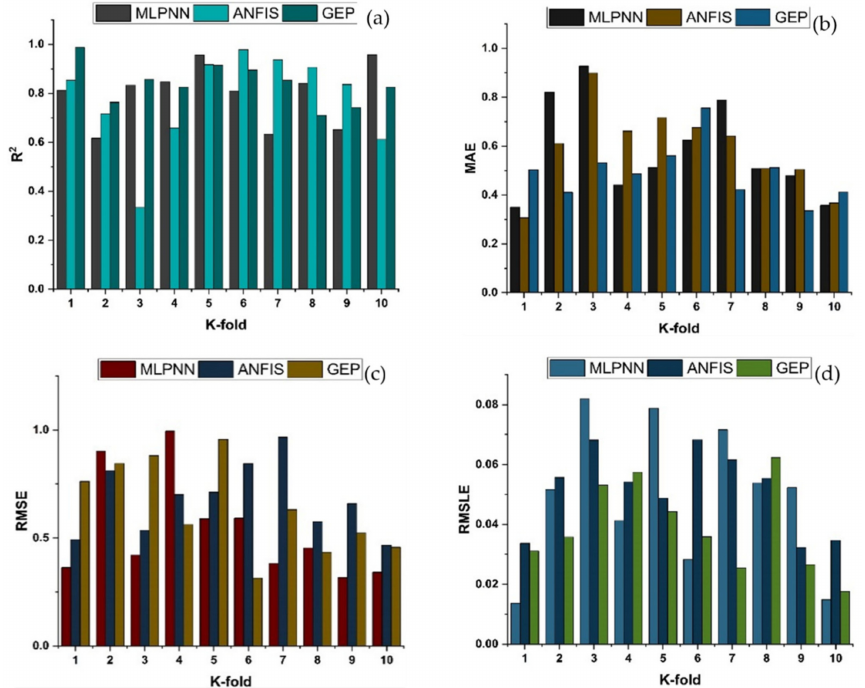
Figure 17. K-fold cross validation of tensile strength for MLPNN, ANFIS and GEP; ( a ) Based on R 2 ; ( b ) Based on MAE; ( c ) based on RMSE; ( d ) based on